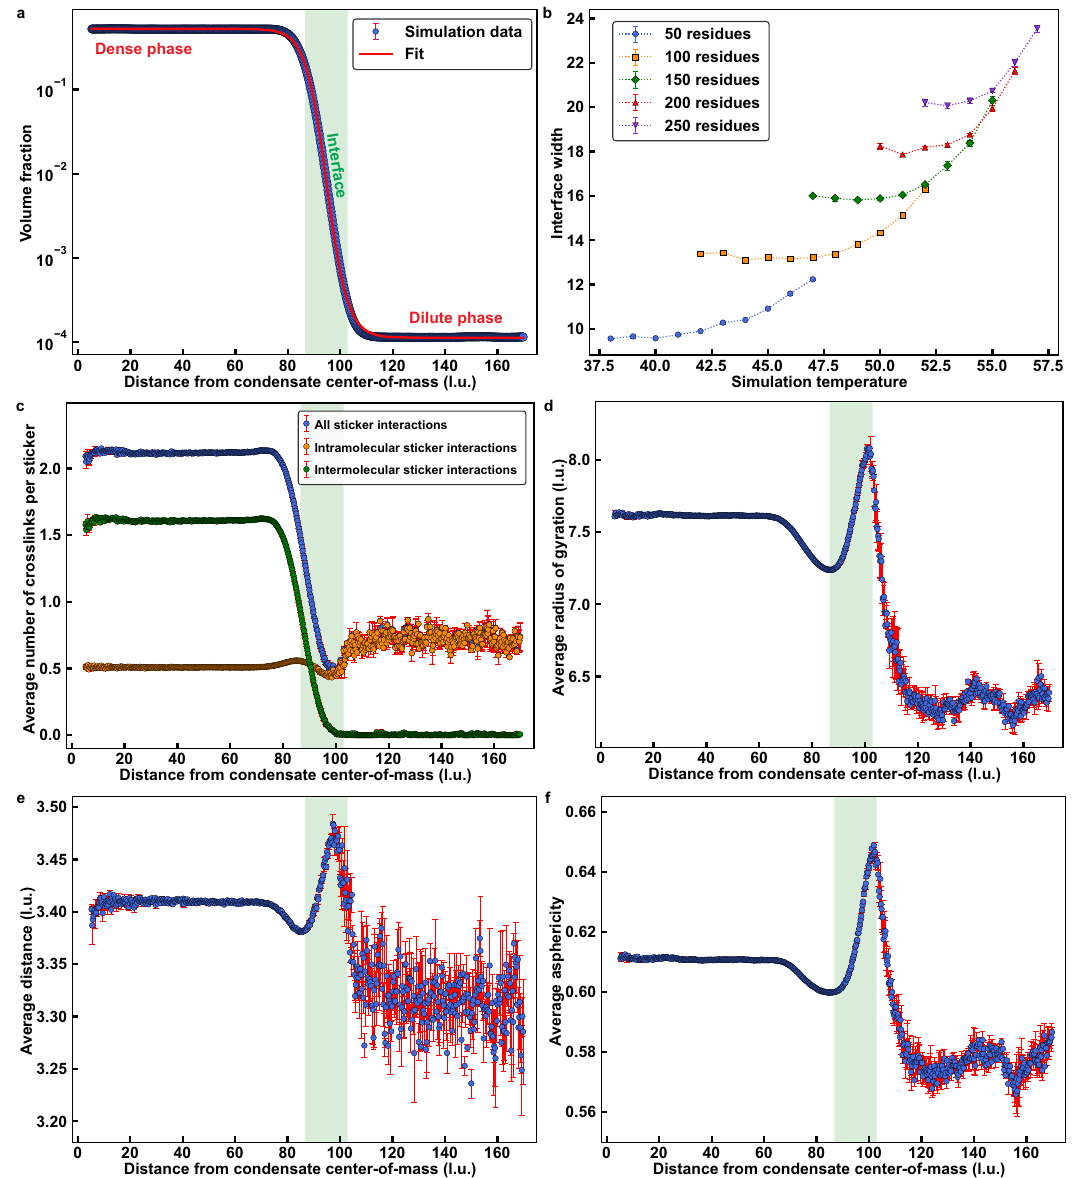
Fig. 4 | Interfaces of condensates have distinctive conformational character- istics.a Arepresentativeradialdensityplotofasimulationofthewild-typeA1-LCD at ω = − 3.38. The solid red curve corresponds to a logistic fi t to the data (see Methods). b The width of the condensate interface versus temperature for simu- lations of homopolymers at different lengths. c Average number of sticker-sticker crosslinks per sticker plotted against the distance from the condensate center-of- massforwild-typeA1-LCDat ω = − 3.38.Depictedarethetotalnumberofcrosslinks (blue), the number of intramolecular crosslinks (orange), and the number of intermolecular crosslinks (green). d Average R g of a chain plotted against the dis- tance from the condensate center-of-mass for the wild-type A1-LCD at ω = − 3.38. e Average distance between residues on the same chain that are separated by